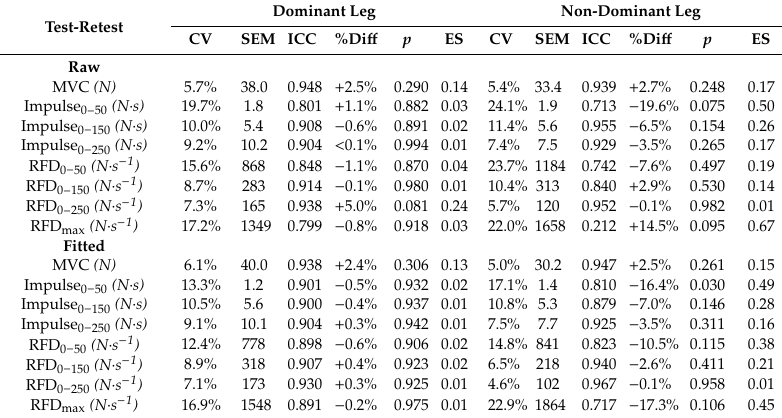
SEM: standard error of measurement, CV: SEM expressed as a coe ffi cient of variation, ICC: intraclass correlation coe ffi cient, Di ff : percentage of change between the average records of each session, p -value: t -test significance, ES: Hedge’s g e ff ect